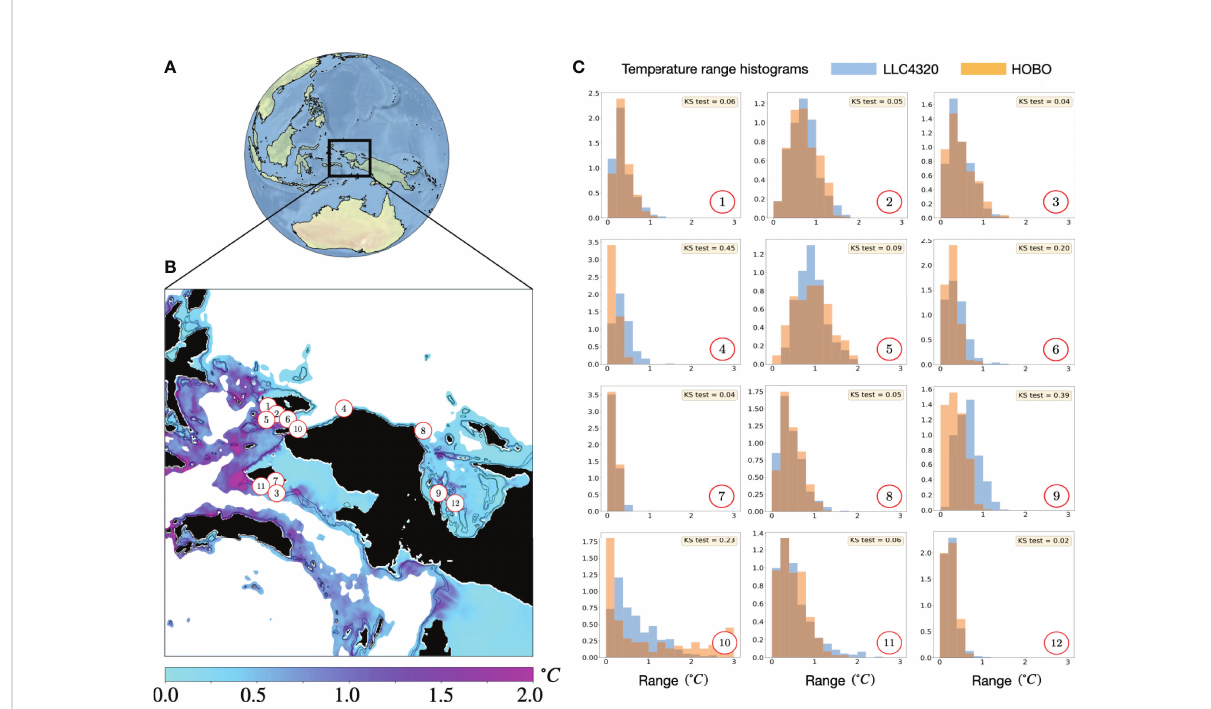
FIGURE 2 Model versus HOBO logger comparisons in West Papua, Indonesia (A) . Twelve loggers were distributed as in (B) , where the colors indicate the mean daily temperature range at 50 m depth. The daily temperature ranges observed by the loggers were used to form probability density functions, which were compared against co-located areas on the model grid (C) . Model and observational PDFs generally show good agreement, as measured by the Kolmogorov-Smirnov (KS)